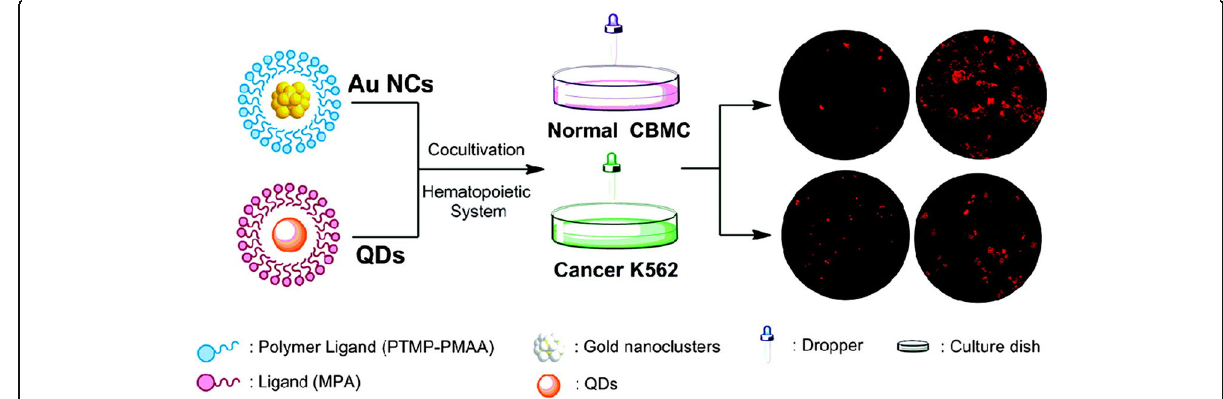
Fig. 5 Labelling of normal and cancer cells with AuNCs and quantum dots (QDs)